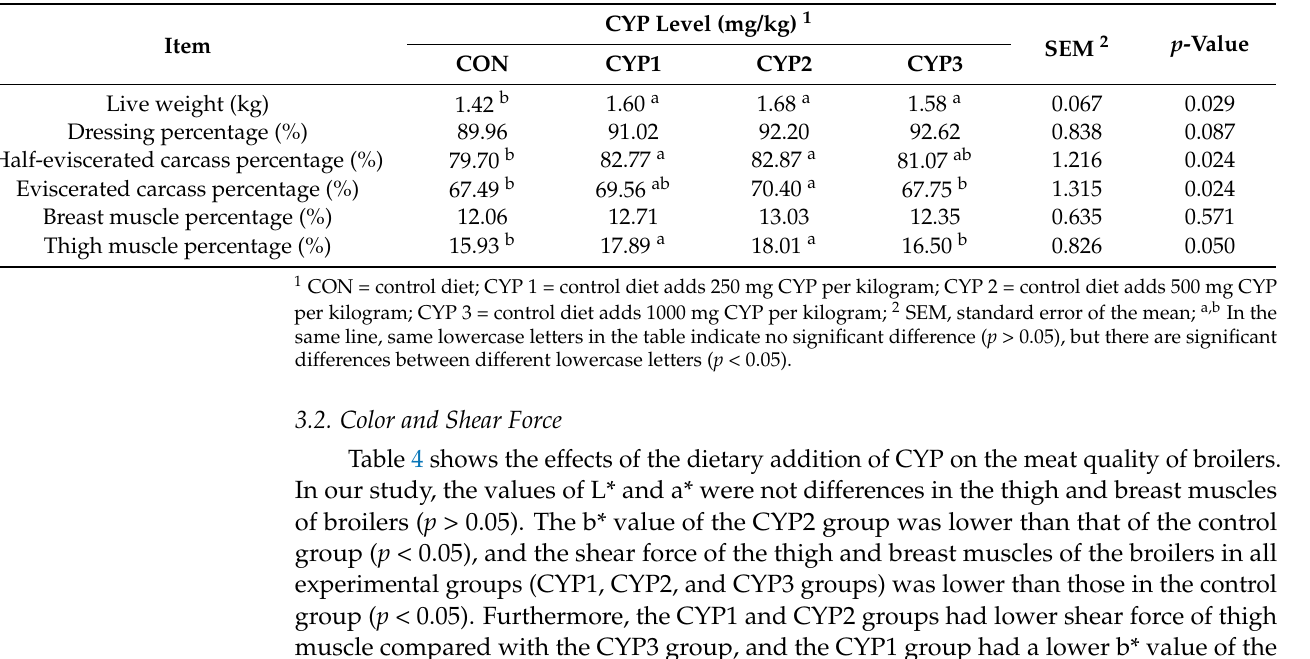
Table 3. Effects of dietary CYP supplementation on the slaughter performance of